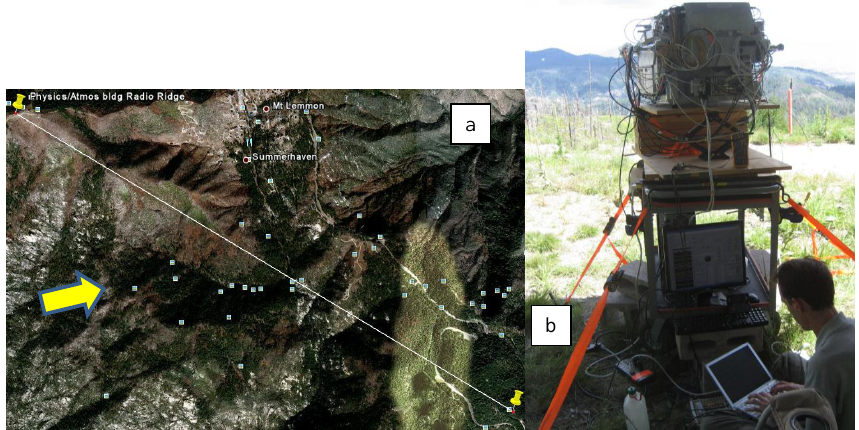
Fig. 8. The Mt. Lemmon (a) to Mt. Bigelow (b) geometry. (b) Abe Young at the ATOMMS-A instrument on Mt. Lemmon. The white dome in the distance in the upper left corner of the picture is the Mt. Bigelow observatory where the ATOMMS-B instrument is located. Yellow arrow indicates the approximate direction of the propagation of the storm on 28 August 2010.